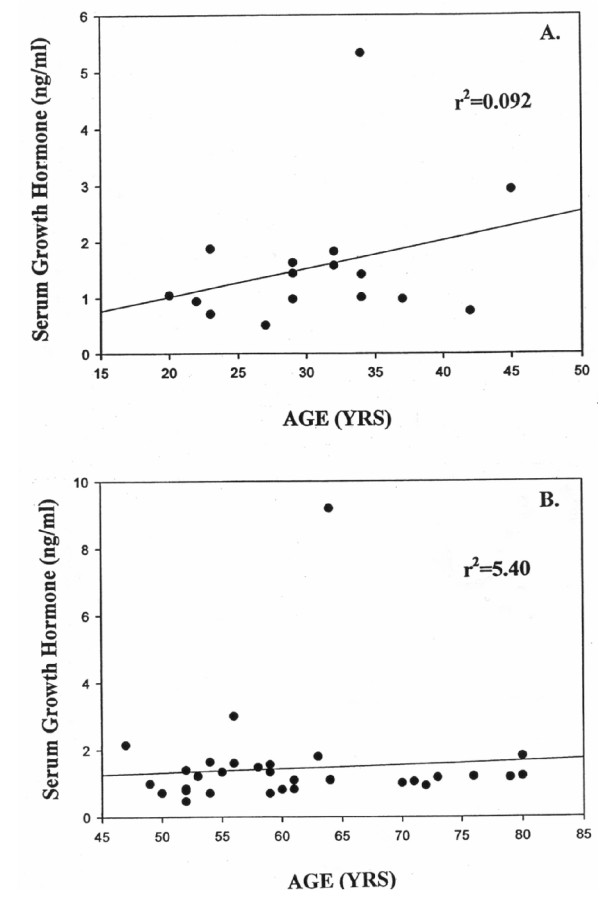
Linear regression analysis. Serum growth hormone levels were plotted as a function of age in young (age range, 20 to 46 yrs) normal female subjects (Panel A) or older (age range, 47 to 80 yrs) normal female subjects (Panel B). The results indicated that serum growth hormone levels correlated with age (r2 = 0.092) only within the circumscribed group of younger normal female subjects.